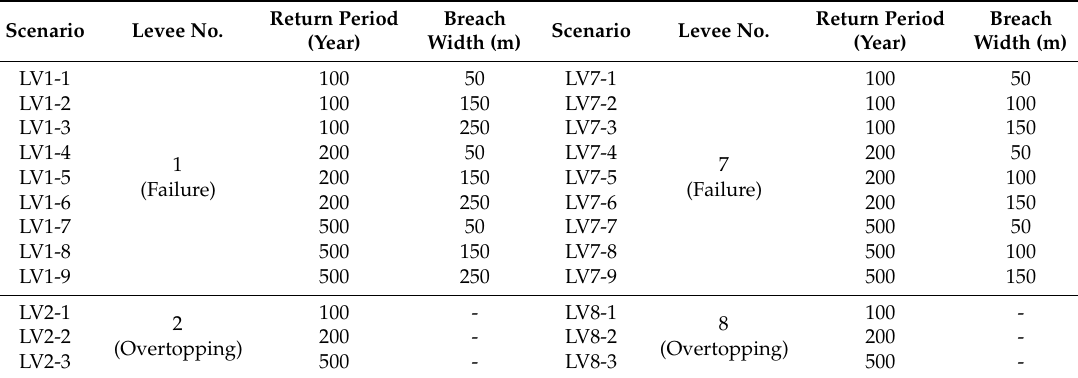
Figure 12. Maximum flood wave arrival times for Levee #1 failure case, ( a ) LV1-1, ( b ) LV1-6, ( c ) LV1-9. Table 2. Definition of scenarios with respect to each